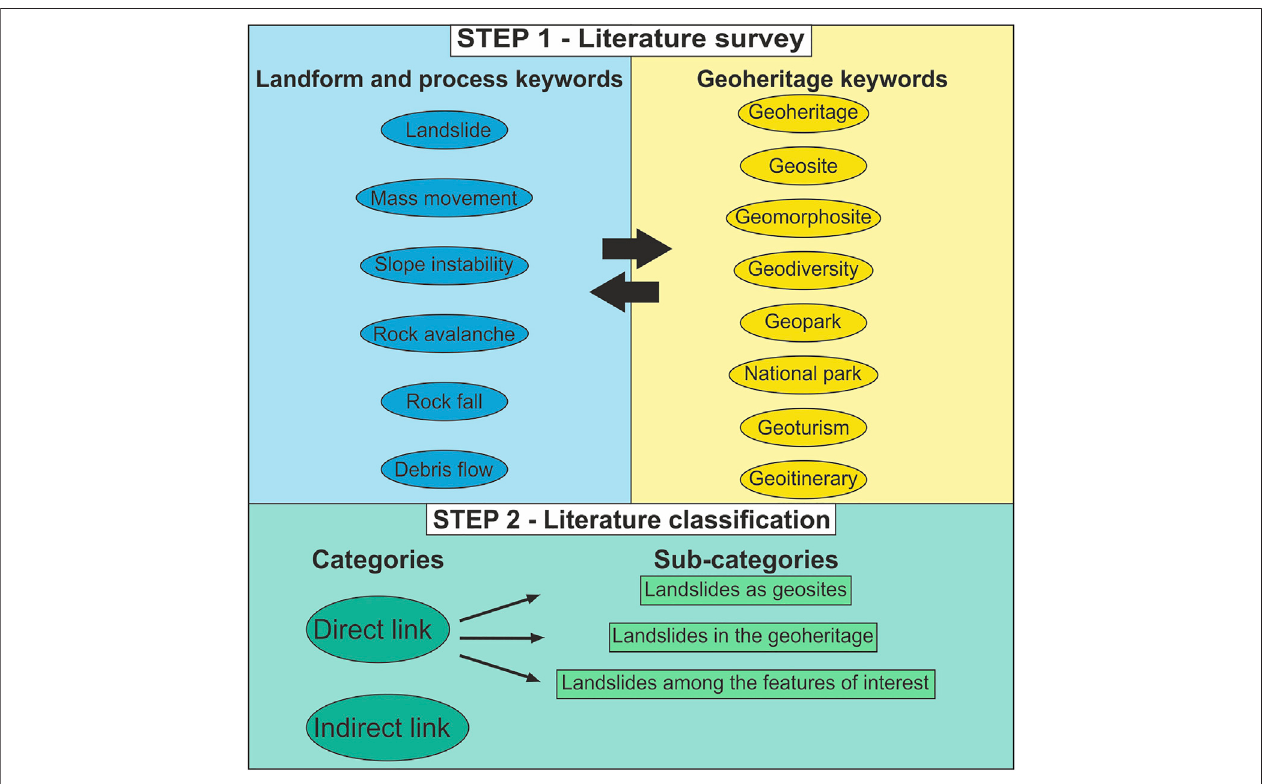
FIGURE 1 | Work fl ow for literature survey and classi fi